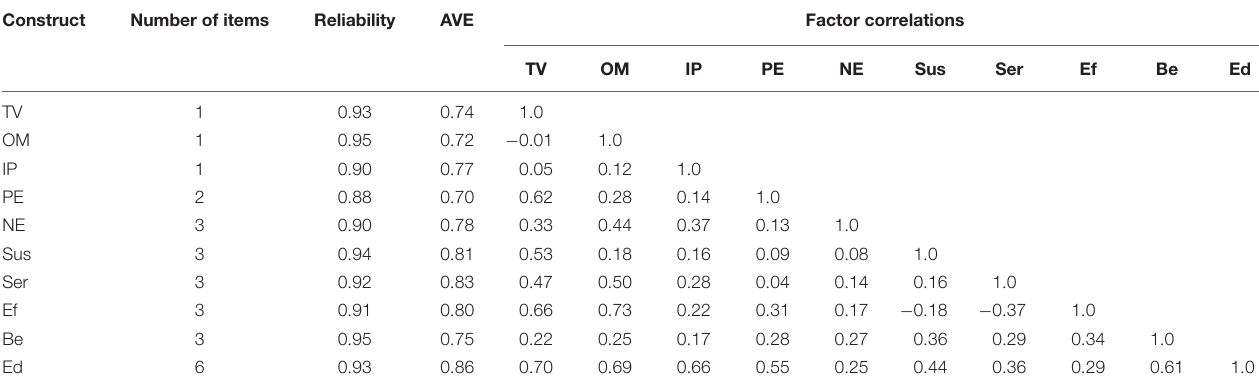
TABLE 2 | Scale properties and